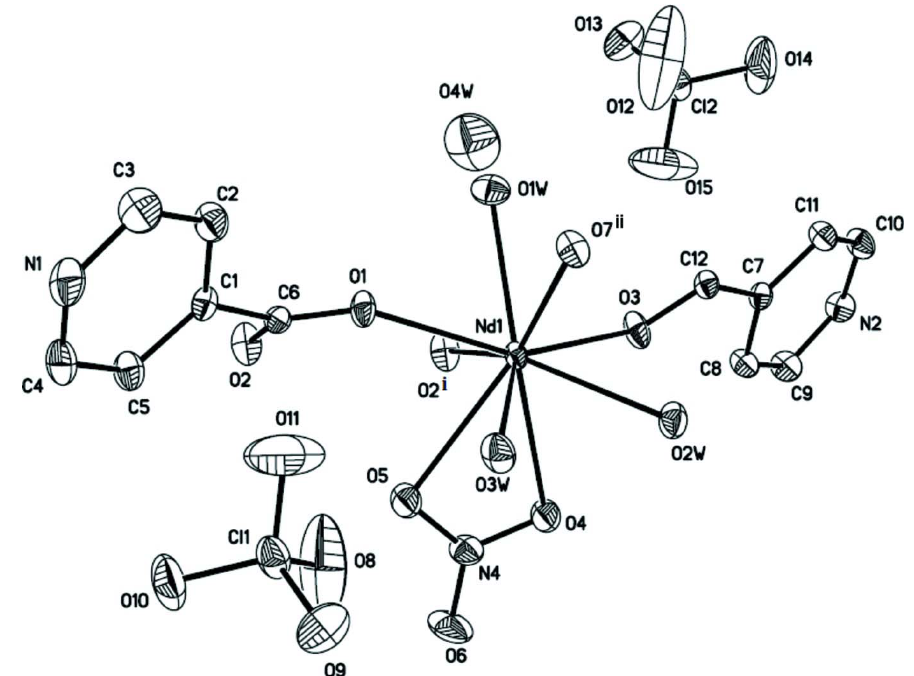
Figure 1 The asymmetric unit of the title compound, extended to show the Nd coordination. Displacement ellipsoids are drawn at the 30% probability level. H atoms have been omitted for clarity. [Symmetry codes: (i) 1 - x , 1 - y , 1 - z ; (ii) 1 - x , - y , 1 - z .]